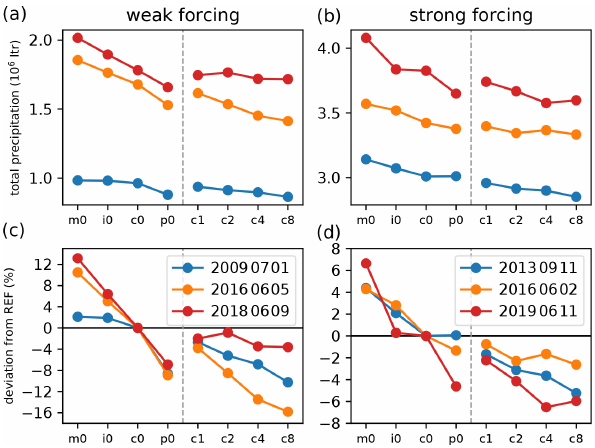
Figure 5. Domain-accumulated precipitation (a, b) and precipita- tion deviation from the respective reference run (c, d) for cases with weak (a, c) and strong (b, d) synoptic-scale forcing. Runs with in- creasing CCN concentrations are labeled m0–p0, whereas runs with increasing shape parameter and continental aerosol assumptions are labeled c1–c8. The reference run is depicted as c0.